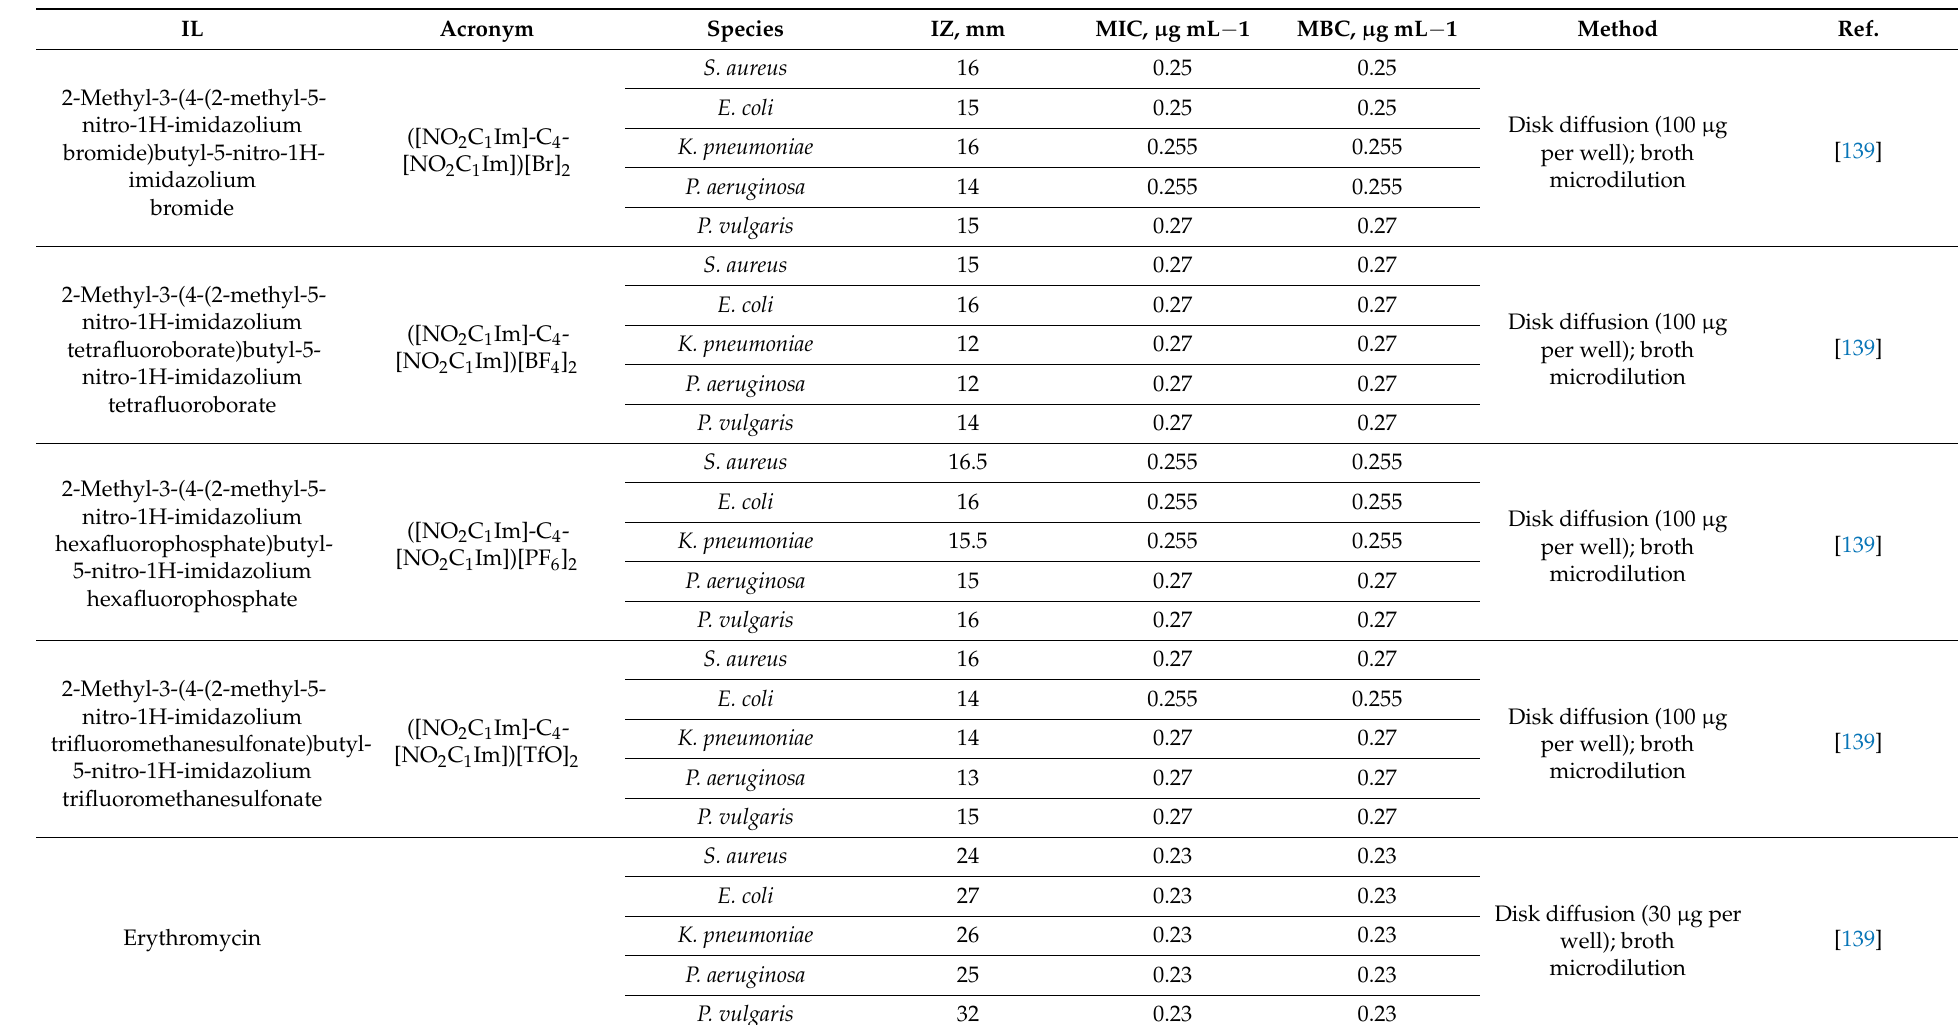
Table 5. Antimicrobial activity of dicationic ILs